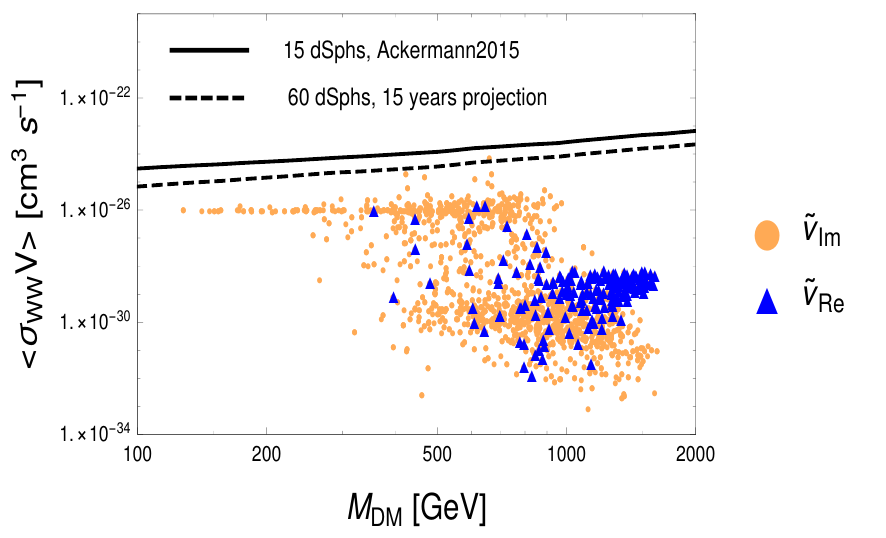
Figure 6 . Thermal cross section for DM DM ! W + W (cid:0) annihilation as predicted by theory as a function of the DM mass, for CP-even (blue) and CP-odd (orange) sneutrinos. Also shown are the FermiLAT limit from dSphs at present (solid black) and as projection for 15 years from now (dashed black). All points obey the relic density upper limit, for which rescaling, where necessary, has been